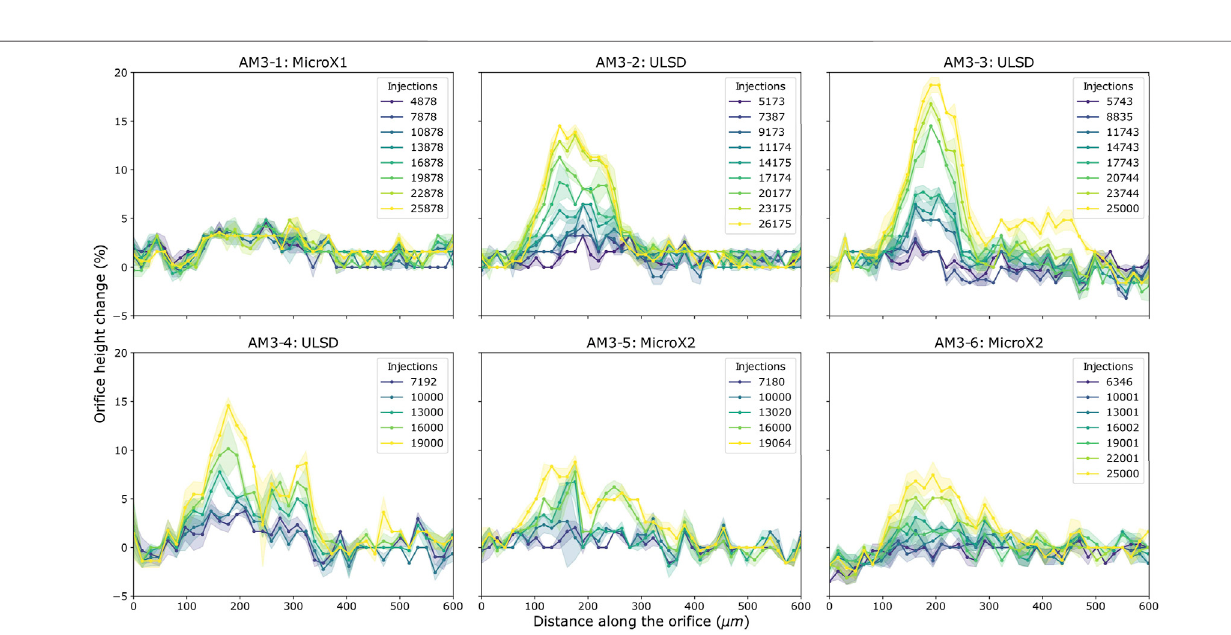
Frontiers in Mechanical Engineering |